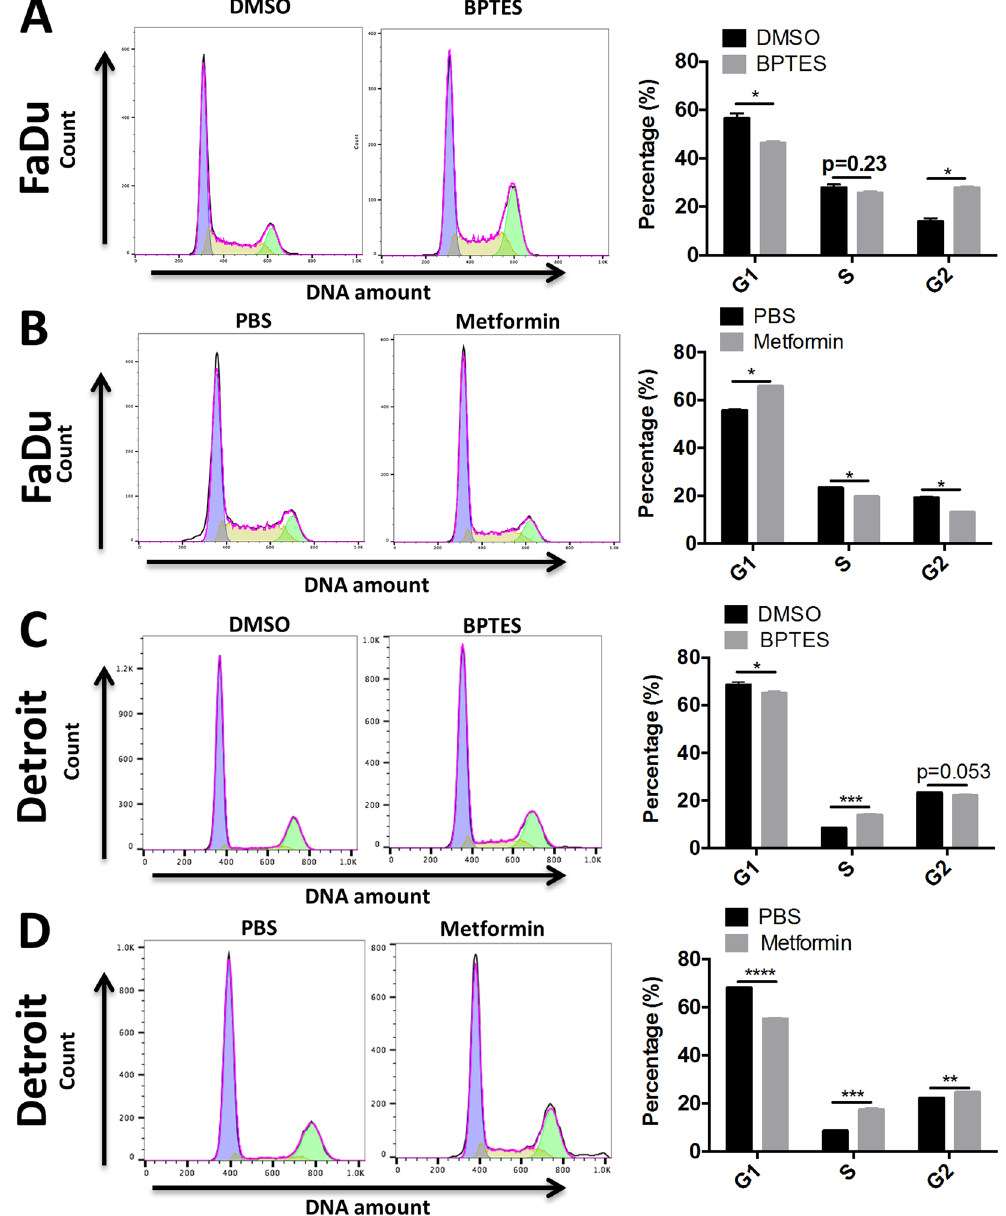
Figure 4. BPTES and metformin induces the cell cycle arrest of FaDu and Detroit cell line. Half-million ( A , B ) FaDu or ( C , D ) Detroit cells were seeded in 6-well plate and treated with BPTES (20 μ M) or metformin (10 mM) for 48 hours. The cell population in each cell cycle phase was determined by flow cytometry analysis after propidium iodide staining. * p < 0.05, ** p < 0.01, *** p ≤ 0.001, **** p <